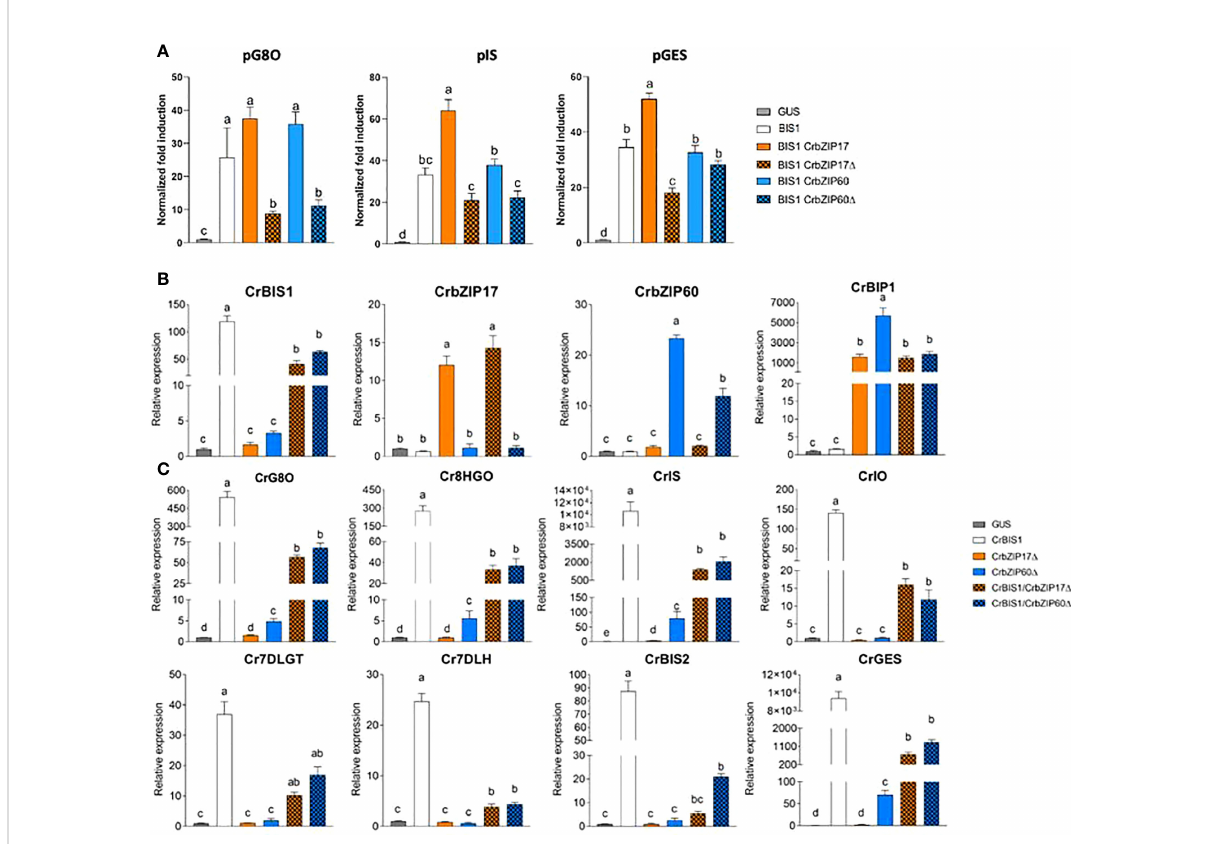
FIGURE 7 C. roseus bZIP17 D and bZIP60 D can repress the transactivation of MIA biosynthesis genes by BIS1. (A) Transient transactivation assays in BY-2 protoplasts using the indicated target promoters fused to the fLUC reporter gene and BIS1 as effector combined with full-length or truncated C. roseus bZIP17 and bZIP60. The Y-axis shows fold change in normalized fLUC activity relative to the control transfection with proCaMV35S:GUS. The error bars designate SE of the mean (n = 4). Different letters indicate statistically signi fi cant differences at P < 0.05 as determined by ANOVA, post hoc Tukey analysis. (B, C) qRT-PCR analysis of CrBIS1 , CrbZIP17 , CrbZIP60 and CrBiP1 genes (B) and of MIA pathway genes (C) in C. roseus fl ower petals transiently overexpressing CrBIS1 , CrbZIP17 D , CrbZIP60 D , CrBIS1/CrbZIP17 D or CrBIS1/CrbZIP60 D under control of the CaMV35S promoter. Control samples were in fi ltrated with the pCaMV35S:GUS construct. The error bars designate SE of the mean (n = 4). Different letters indicate statistically signi fi cant differences at P < 0.05, as determined by ANOVA, post hoc Tukey